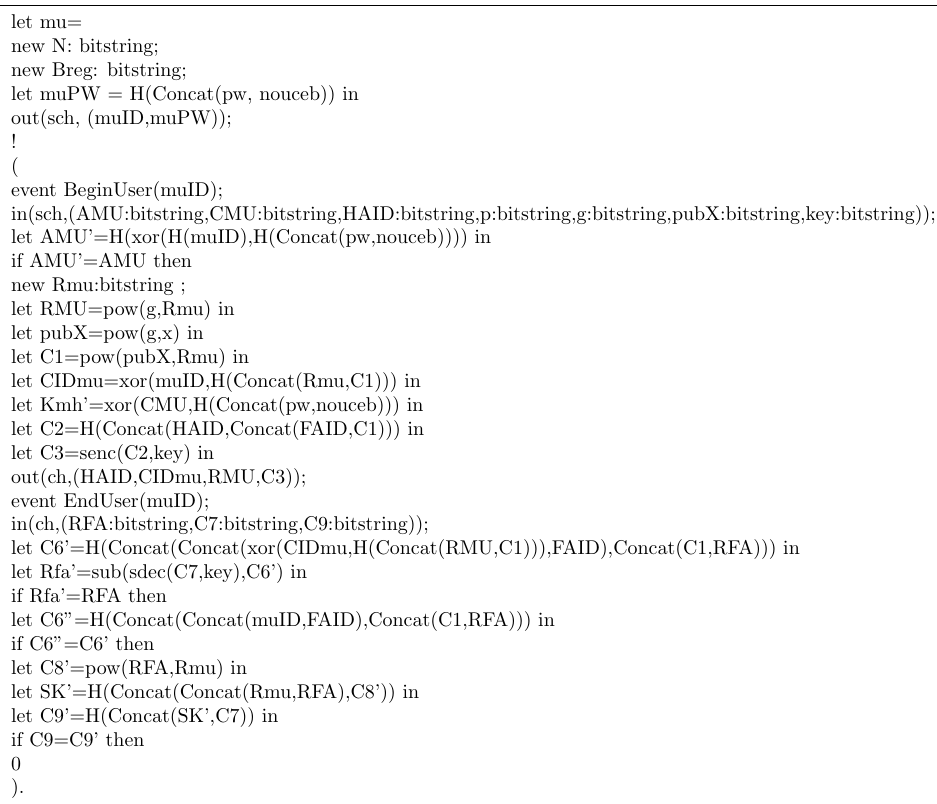
Figure 4. Verification code for MU.